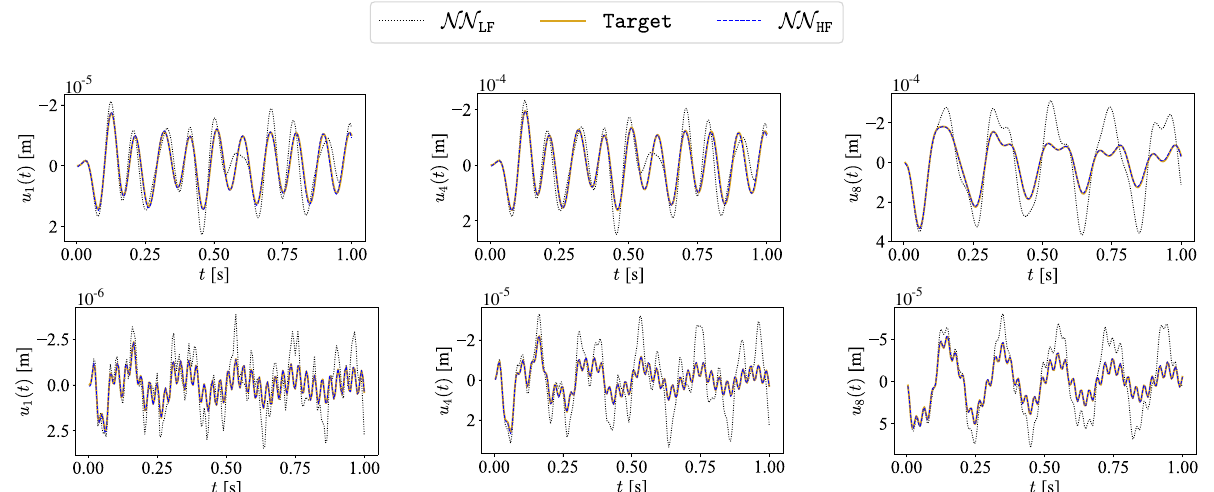
Figure 2. Cantilever beam: exemplary comparisons of u 1 ( t ) , u 4 ( t ) and u 8 ( t ) displacement time histories provided by N N LF and N N HF , with the target